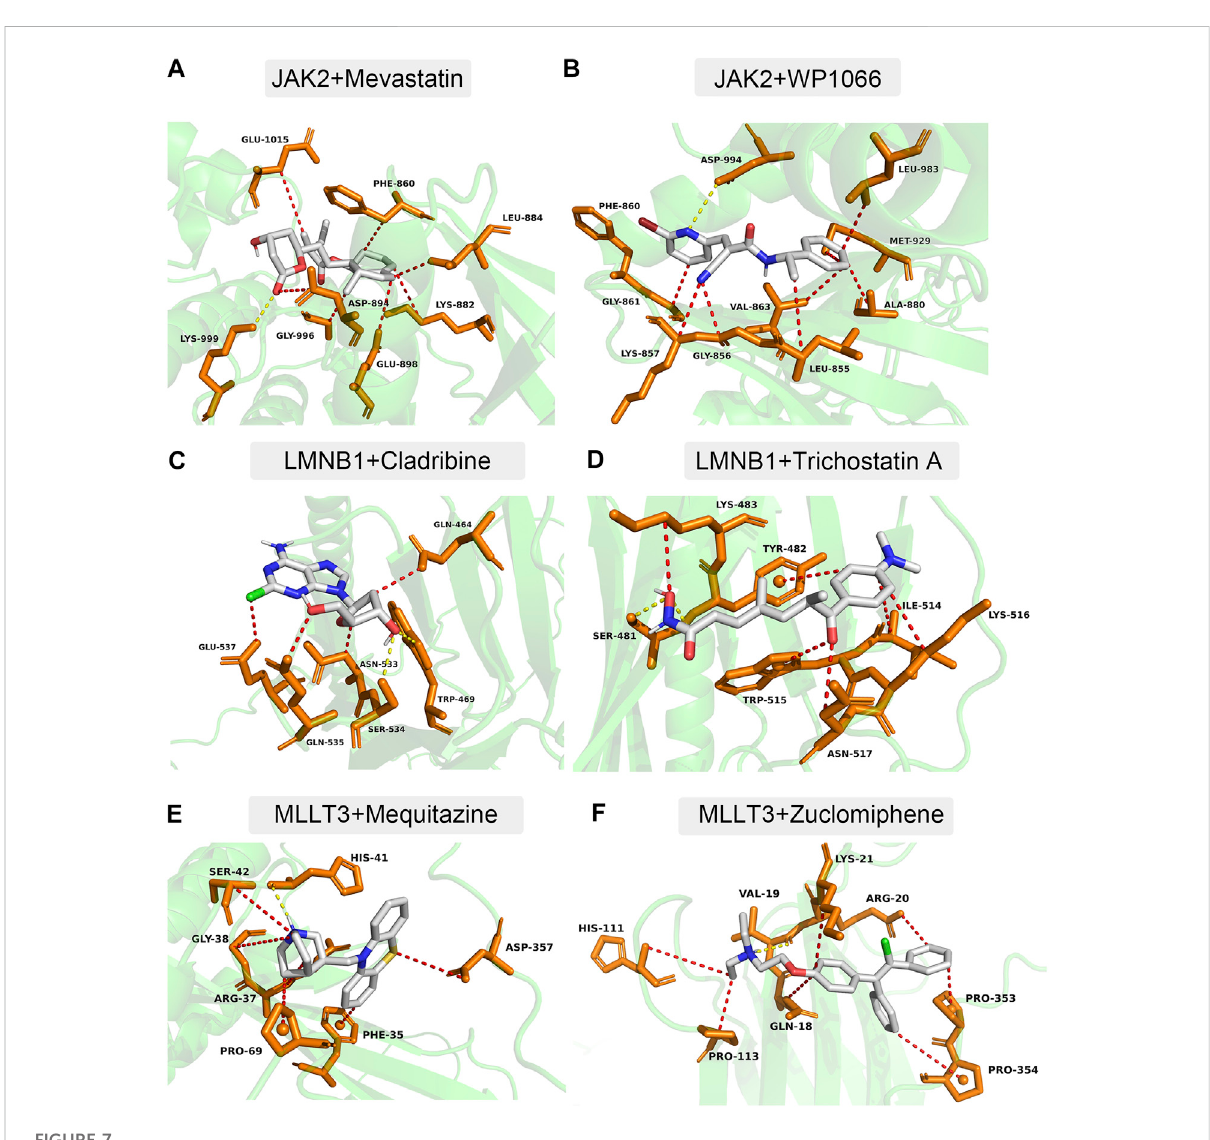
FIGURE 7 Docking simulation of proteins and small molecule compounds. (A) JAK2 and Mevastatin. (B) JAK2 and WP1066. (C) LMNB1 and Cladribine. (D) LMNB1 and Trichostatin (A) . (E) MLLT3 and Mequitazine. (F) MLLT3 and